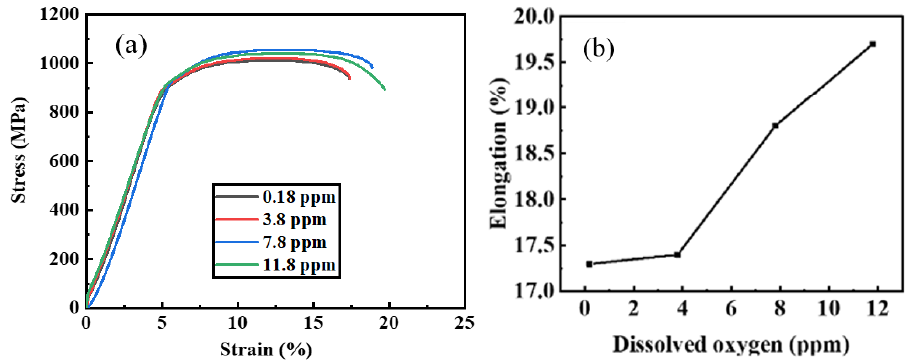
Figure 12. The stress – strain curves ( a ) and elongation ( b ) of Ti6Al4V alloy after 1 h charging under different DO concentrations.